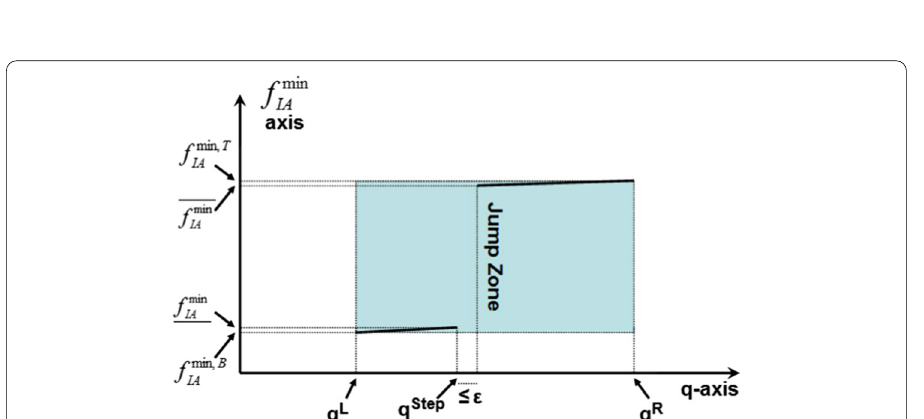
Fig. 4 Visualization of the jump zone for a q versus f min IA